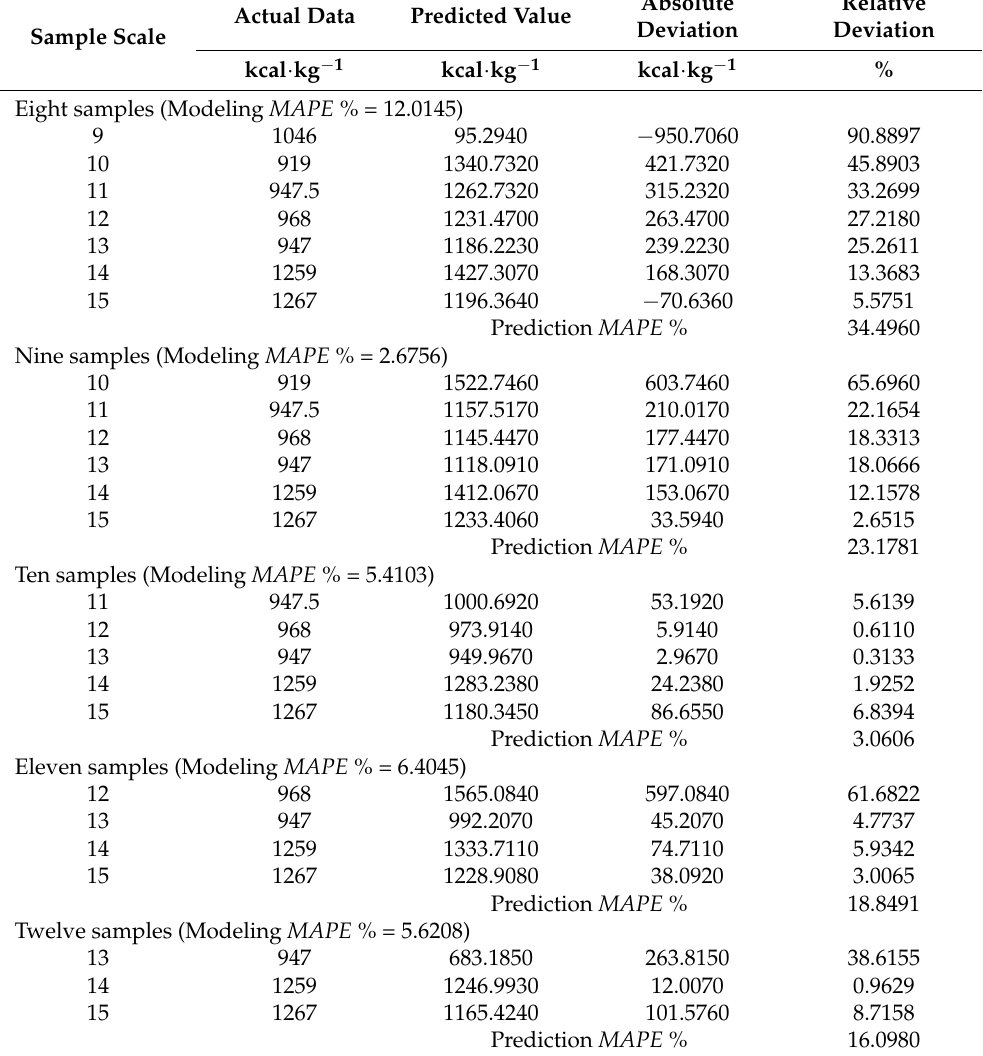
Table 7. Comparison of POBGM (1, 5) model prediction accuracy when using a different sample scale.